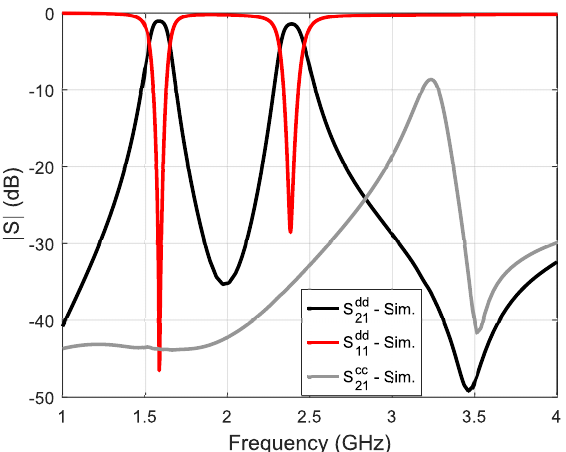
Figure 4. Simulated response of the proposed multilayered balanced dual-band bandpass filter. The dimensions (in mm) used for the structure in Figure 2 that give rise to this response are: (i) top layer: = 0.2, l t = 1.3, l t = 5.05, l t = 26.6, s t = 0.2; (ii) middle layer: w b t = 5.8, w 0 = 5.1, w 1 = 0.2, w t 2 3 1 1 1 = 0.4, w b = 0.5, l b = 27.2, l b = 5.7, l b = 4.95, l b = 1.5, l b = 1.575, s b = w b 2 3 2 3 5 1 4 1